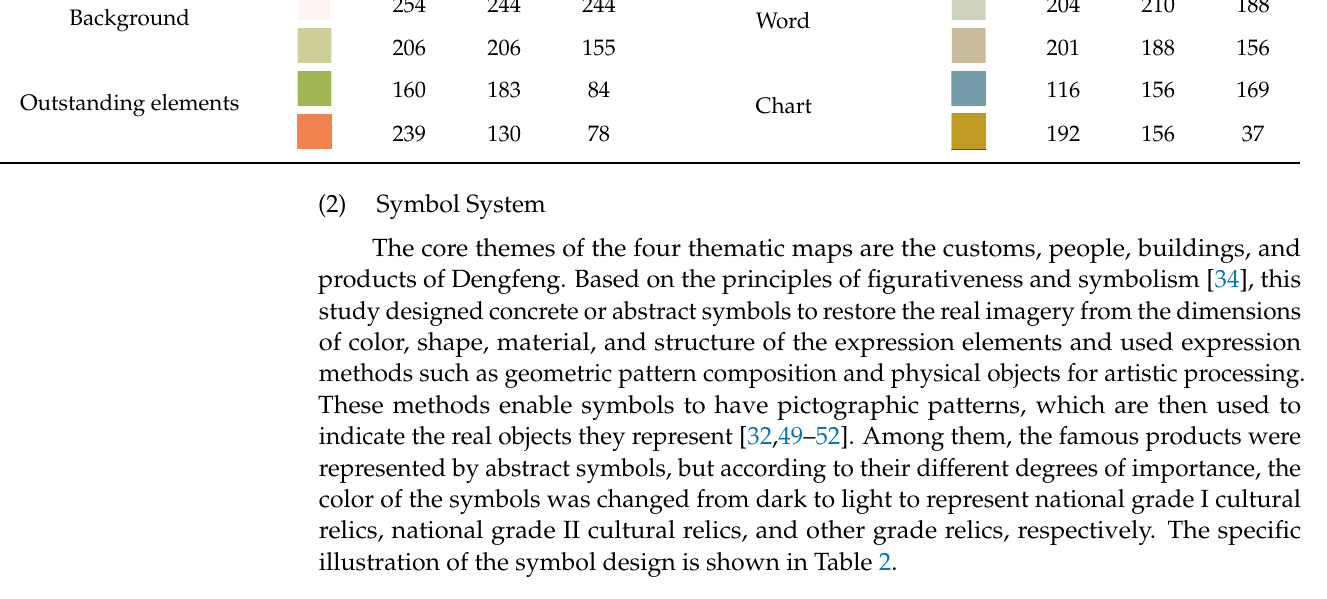
Table 1. The color system of the thematic map. Map Elements